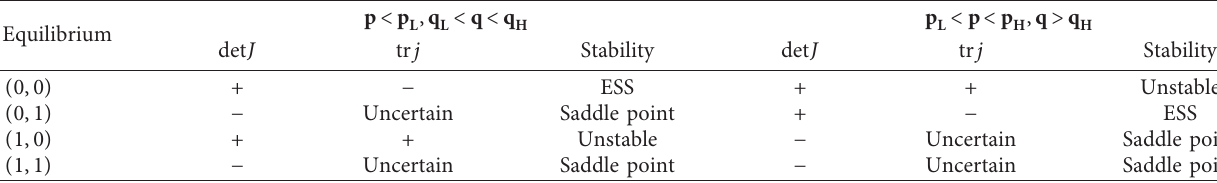
Table 3: Equilibrium point local stability.